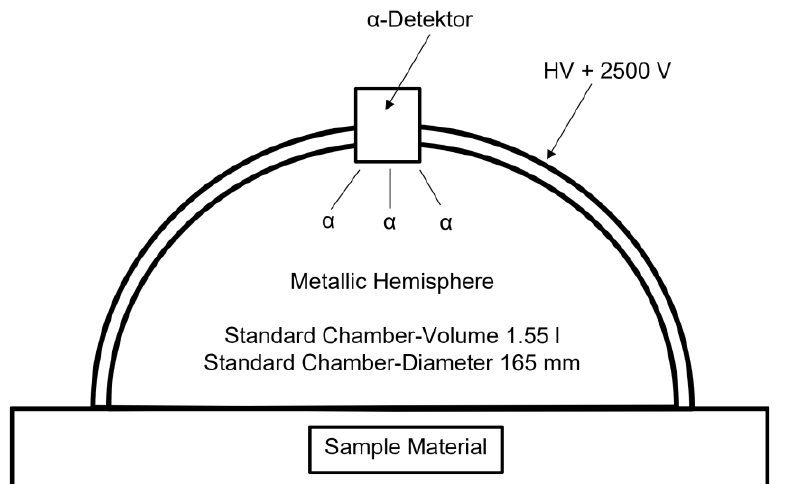
Figure 7. Schematic diagram of ERS-2 (modified from